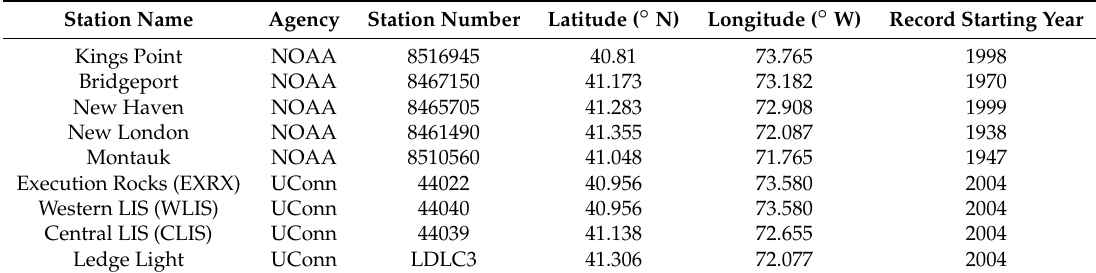
Figure 1. Model domain, mesh, and bathymetry (color ramp) of the Long Island Sound FVCOM-SWAVE model, and locations of NOAA tide gauge stations (green squares), buoys (red triangles), airports (yellow airplane symbols) and coastal points (blue stars) where model results are evaluated. Table 1. The locations of the gauge and buoys from